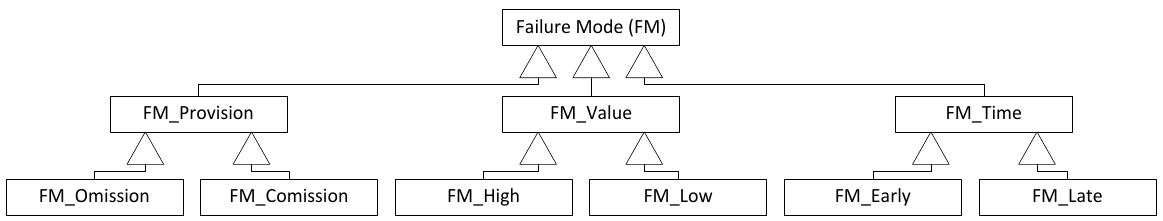
Figure 2. Failure Type System (adapted from